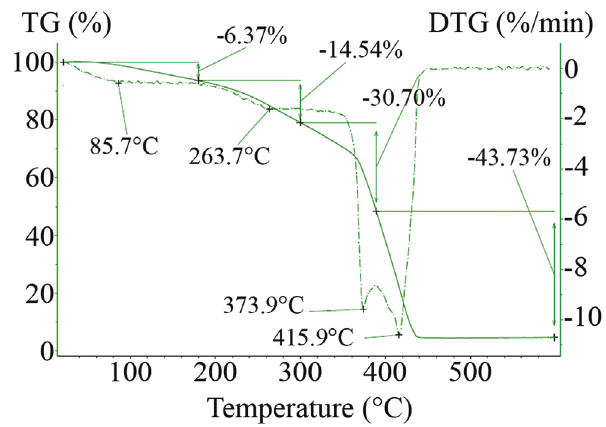
Figure 5: TGA and DTG curves of the synthesized INPs; the weight loss below 263.7°C was due to water evaporation and above 263.7°C was due to decomposition of biologic